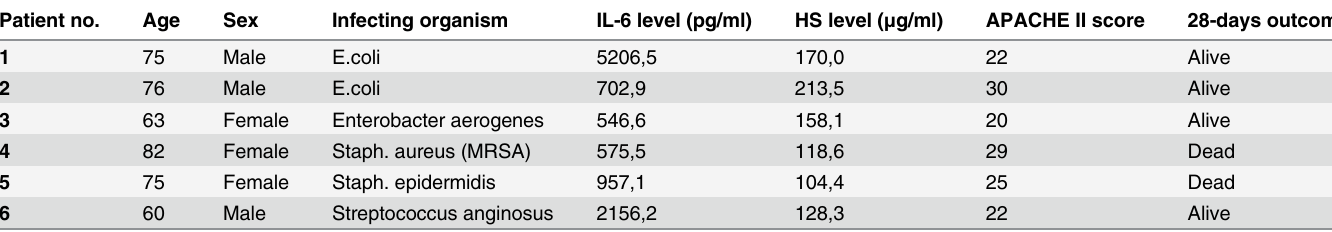
Table 1. Characteristics of serum from septic shock patients used for cell stimulation. Patient